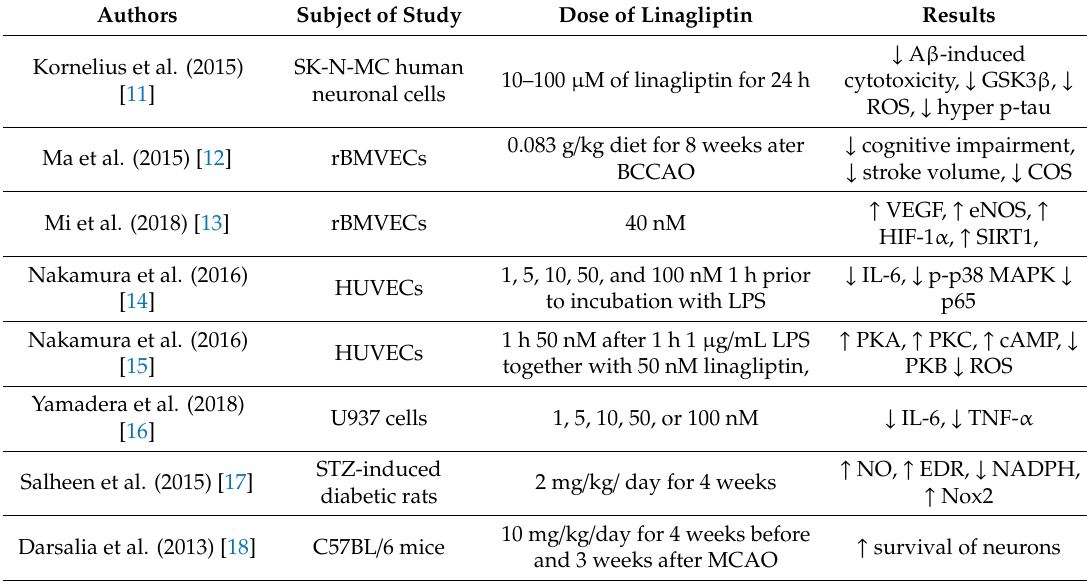
Table 1. Summary of reviewed results. Note: ↓ = reduction, ↑ = increase, A β = amyloid beta, GSK3 β = Glycogen synthase kinase 3 beta, ROS = reactive oxygen species, p- = phosphorylation ,